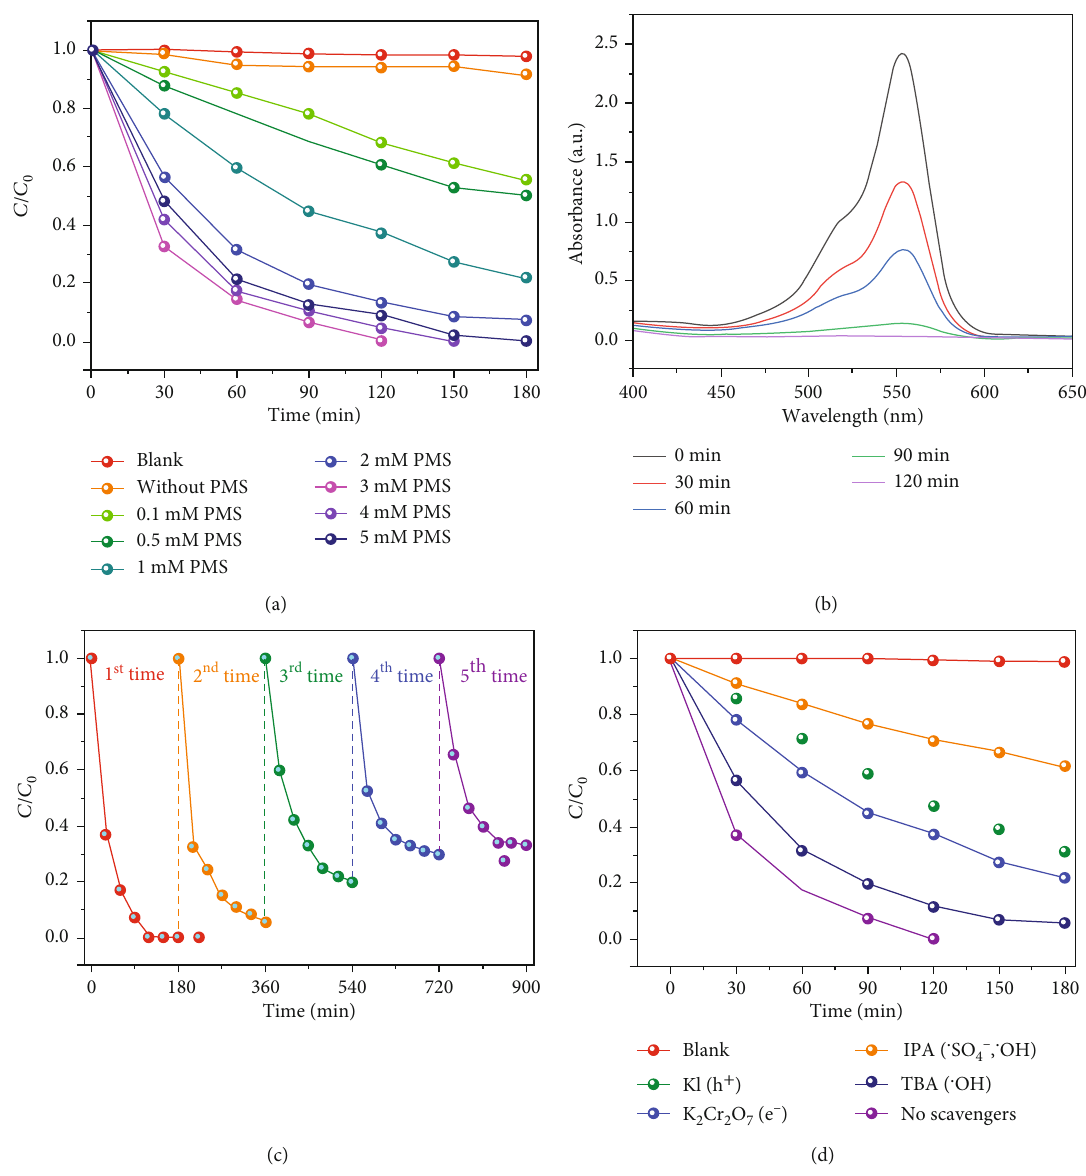
Figure 3: (a) Photocatalytic degradation of the cPVC/TNT nanocomposite against RhB upon PMS activation with a concentration varied from 0.1mM to 5mM under visible light. (b) Absorption spectra of RhB of the cPVC/TNT nanocomposite after being activated with PMS at a concentration of 3mM during the photocatalytic reaction. (c) The photocatalytic performance of the cPVC/TNT nanocomposite after being recycled fi ve repeated times. (d) Radical trapping test